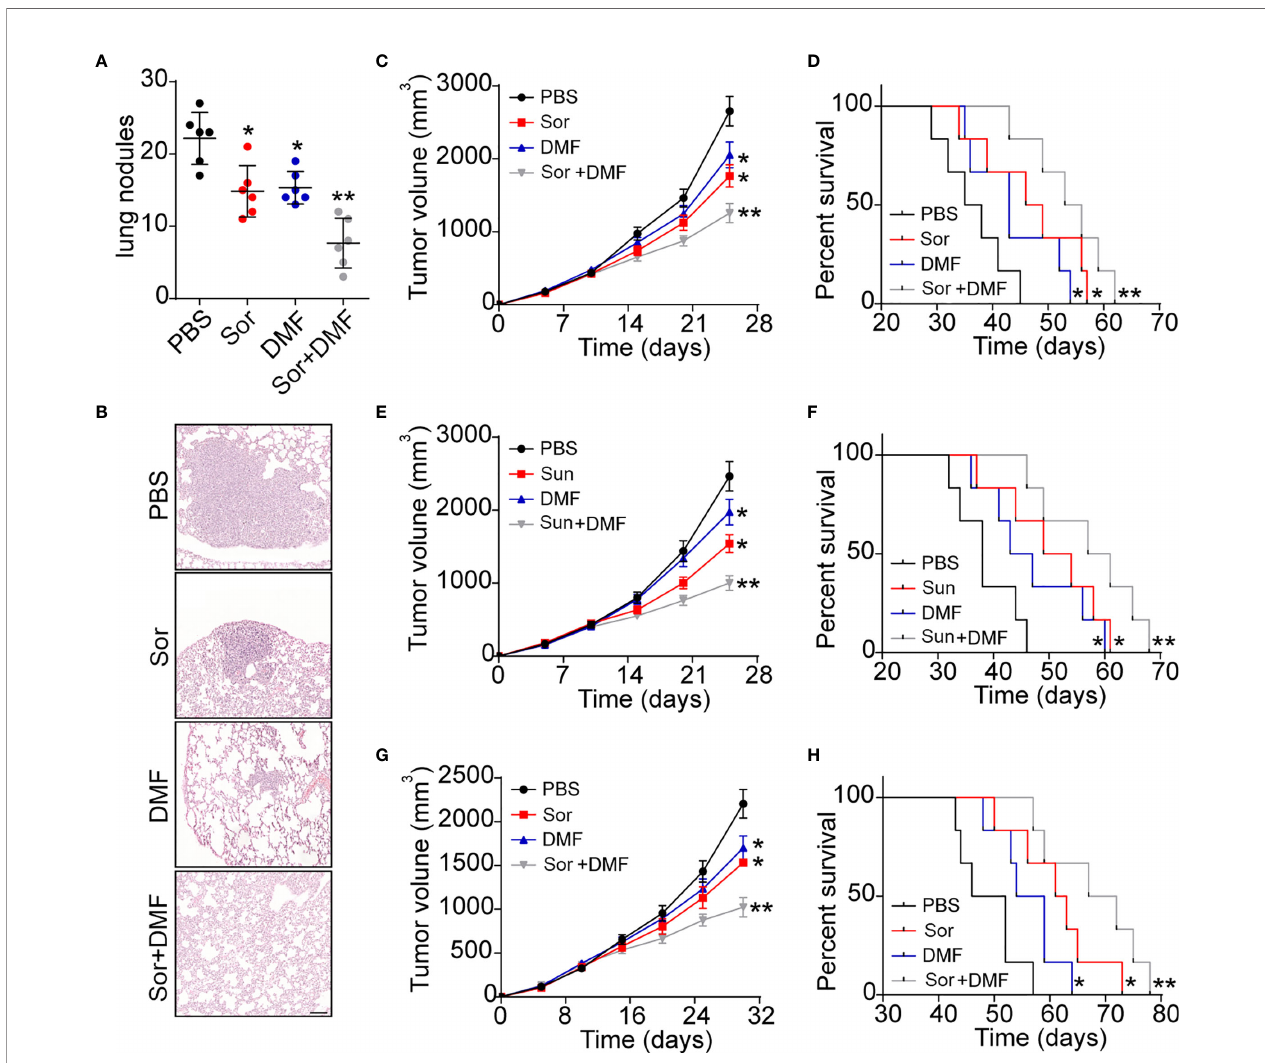
FIGURE 5 | Blockade of AhR signals improved outcome of chemotherapy in renal cancer. (A) The metastasis lung nodules of Renca lung metastasis mice models treated with PBS, DMF, Sor and Sor combined with DMF. (B) Representative images of lung tissues from (A) . The scale bar is 200 m m. (C) The tumor volume of subcutaneous Renca bearing mice treated with PBS, DMF, Sor and Sor combined with DMF. (D) The survival time of subcutaneous Renca bearing mice treated with PBS, DMF, Sor and Sor combined with DMF. (E) The tumor volume of subcutaneous Renca bearing mice treated with PBS, DMF, Sun and Sun combined with DMF. (F) The survival time of subcutaneous Renca bearing mice treated with PBS, DMF, Sun and Sun combined with DMF. (G) The tumor volume of subcutaneous A498 bearing mice treated with PBS, DMF, Sor and Sor combined with DMF. (H) The survival time of subcutaneous A498 bearing mice treated with PBS, DMF, Sor and Sor combined with DMF. Mean ± SEM, n.s, no signi fi cant difference; *p < 0.05, **p <